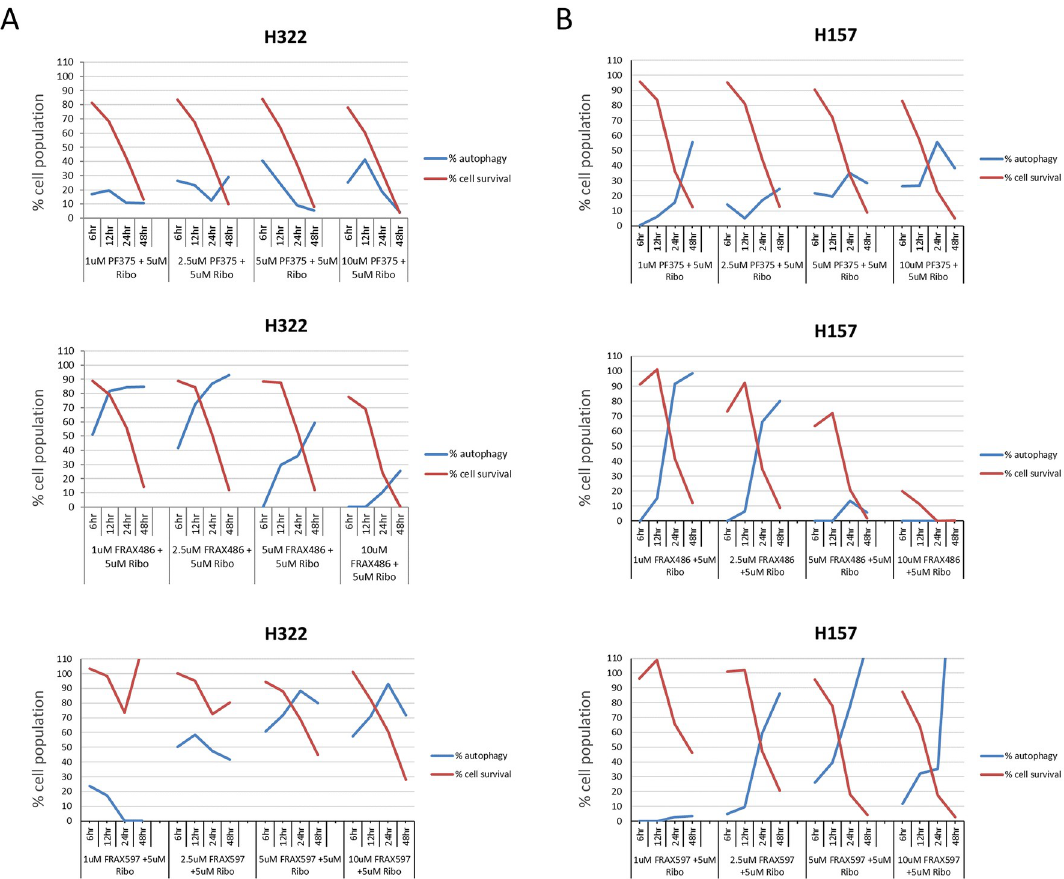
Fig 5. Autophagy and cell survival. Cells were treated with increasing concentrations of PF03758309, FRAX486 or FRAX597 in combination with 5 μ M Ribociclib. After 6, 12, 24 and 48 hours, the cells were stained with Hoechst and Cyto-ID green to detect the cellular nucleus and autophagosomes, respectively. Cell survival was reported as a percentage of viable cells compared to the vehicle control, and autophagy was reported as number positive vesicles per viable cell normalized to vehicle control. Red lines % cell survival, blue lines % autophagy. Results shown in A and B are representative of H322 (n = 3) and H157 (n = 1) cell lines, respectively. The very high calculated percentage of cells in autophagy observed in H157 cells at high drug concentrations and later time points results from the fact that there are very few surviving cells under the conditions, and they all have